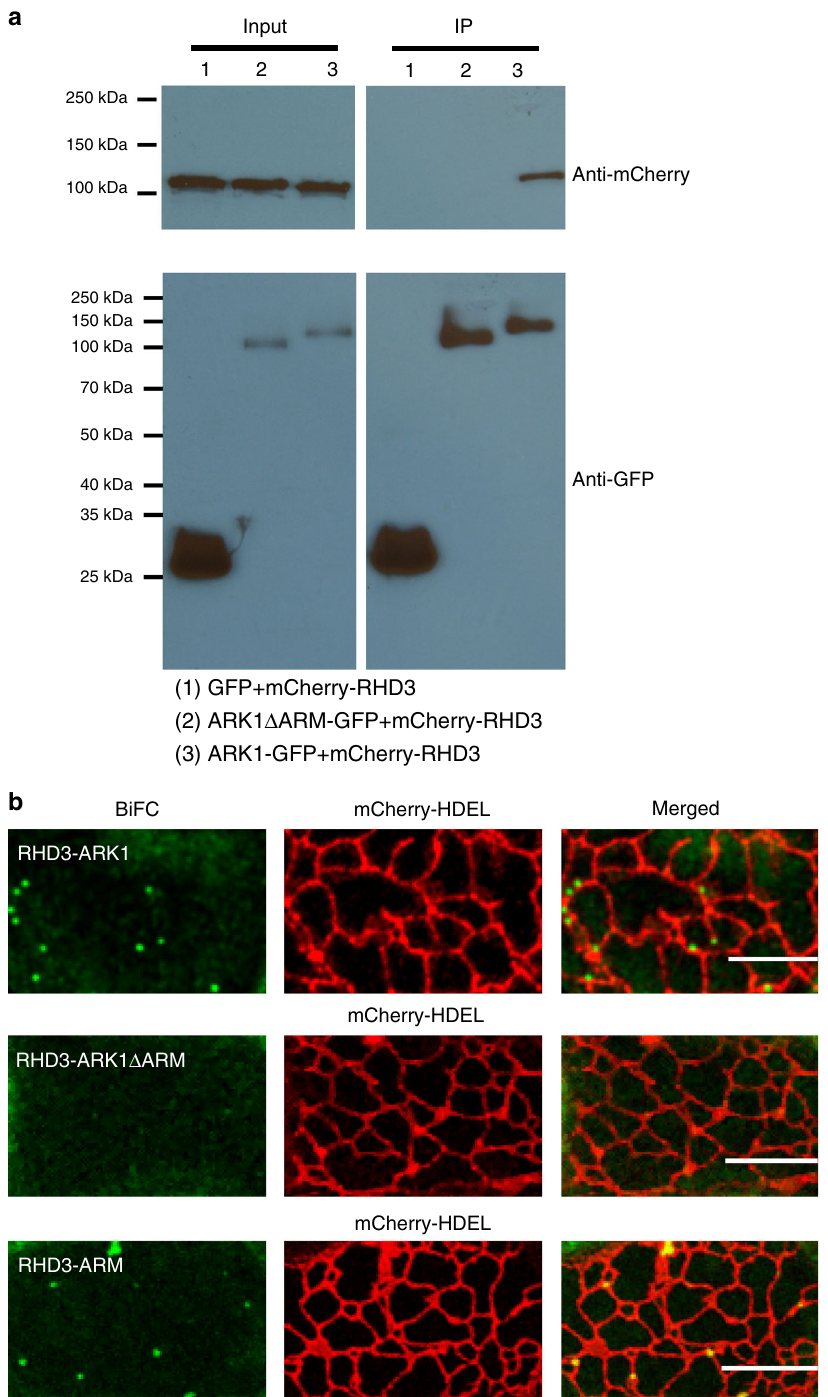
Fig. 8 ARK1, but not ARK1 Δ ARM interacts with RHD3. a Co-puri fi cation of mCherry-RHD3 with ARK1 – GFP (line 3) but not with ARK1 Δ ARM (line 2) or GFP (line 1) using GFP-trap. mCherry-RHD3 was detected by anti-RFP; ARK1 – GFP, ARK1 Δ ARM, or GFP was detected by anti-GFP. Input is a total protein extract samples; IP is puri fi ed samples with GFP-trap. b Venus-based Bi-molecular fl uorescence complementation (BiFC) analyses of nVenus-RHD3 and ARK1-cVenus or ARK1 Δ ARM-cVenus or ARM-cVenus. mCherry-HDEL from the same gene cassette was used as an expression indicator. This experiment was independently repeated three times. Scale bars = 10 μ m. Source Data are